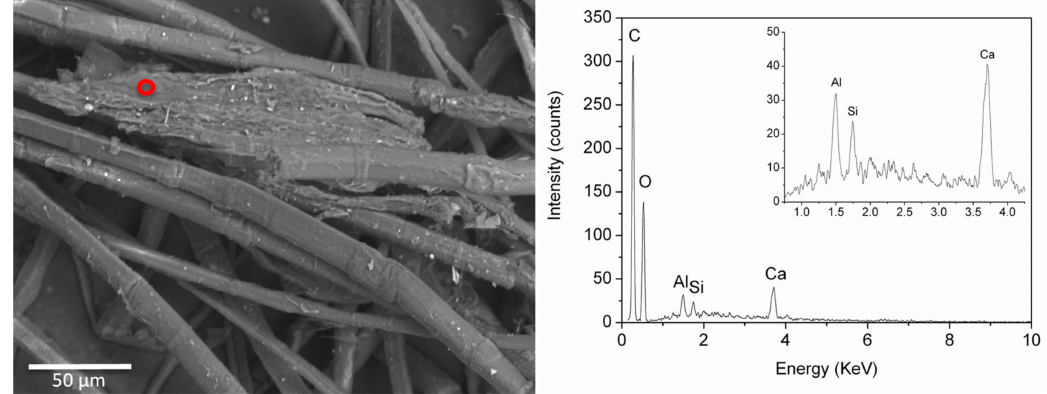
Figure 8. Back-scattered electron SEM image of sample BM4 with an EDS spectrum obtained from the coloured structures. Signals from the inorganic components are highlighted in the